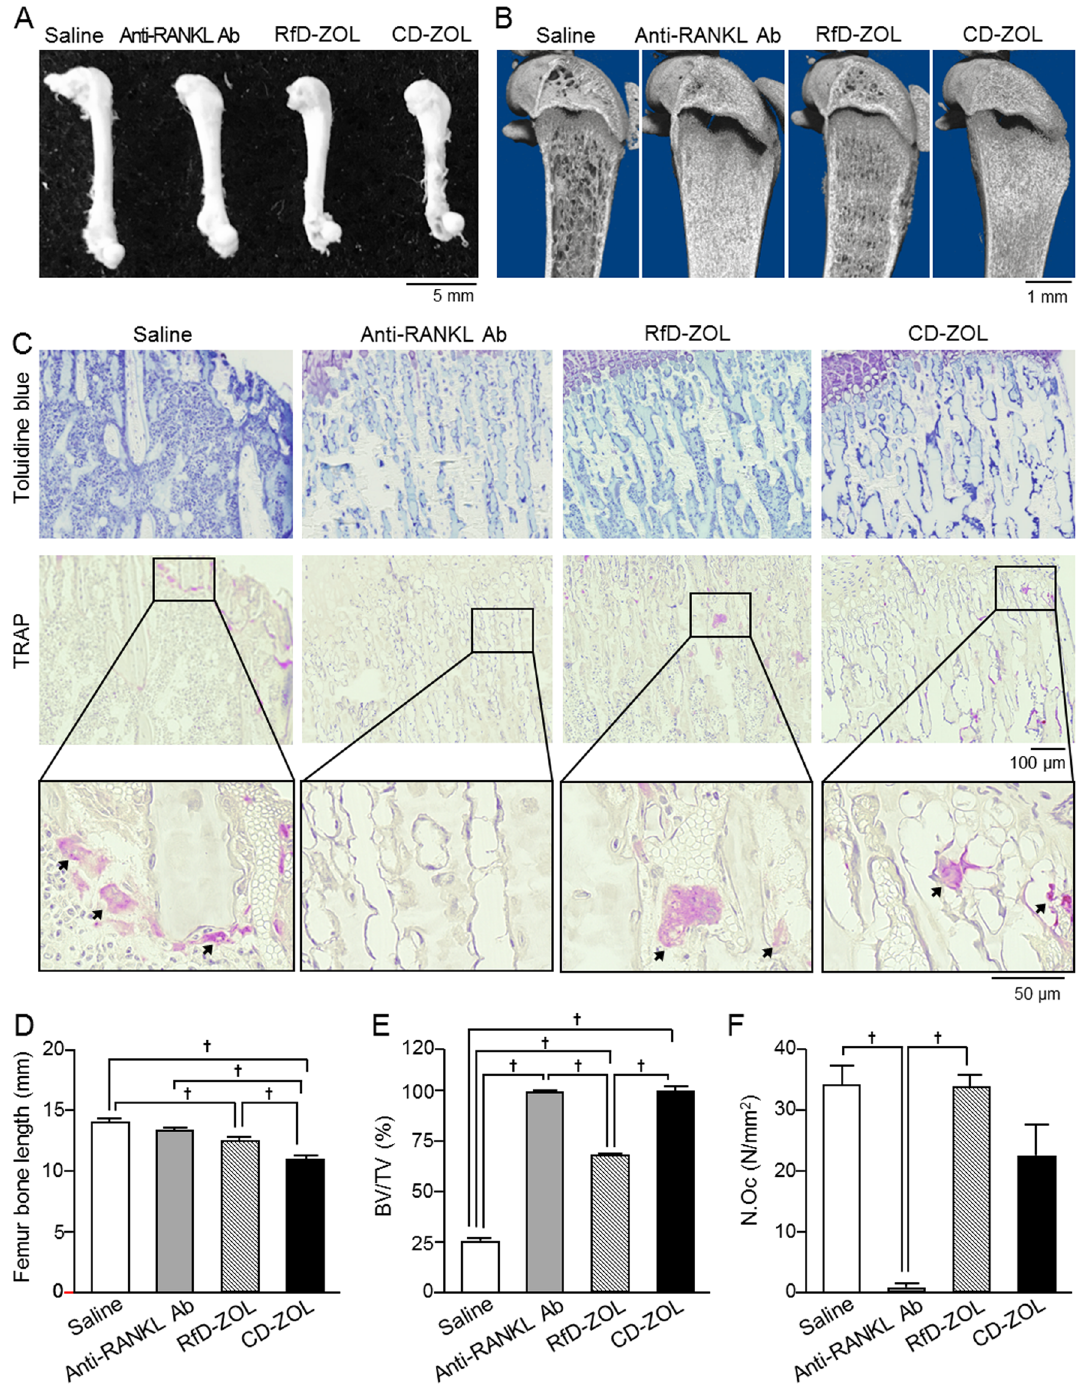
Figure 2. Effects of long-term administrations of anti-RANKL antibody or ZOL on femur and tibia. ( A ) Whole femur appearance. ( B ) Micro-computed tomography ( μ CT) findings of distal femurs in 8-week-old mice administered saline, anti-RANKL antibody (Ab) at 2.5 mg/kg, RfD-ZOL at 0.08 mg/kg, or CD-ZOL at 3.0 mg/ kg weekly for 7 weeks. ( C ) Findings following toluidine blue staining (upper) and TRAP staining (middle and lower) of proximal tibiae growth plate obtained from 8-week-old mice after weekly administrations of each drug for 7 weeks. Higher magnification images of black-boxed regions in middle panels are shown in lower panels. Arrows indicate TRAP-positive cells. Representative results are shown in ( A – C ). ( D ) Femur bone length. ( E ) Bone volume/tissue volume (BV/TV) ratios were determined by μ CT (saline, n = 6; anti-RANKL Ab, n = 5; Rfd-ZOL, n = 6, CD-ZOL, n = 5). ( F ) Number of osteoclasts (N.Oc) was determined in proximal tibiae following TRAP staining. Four mice from each of the saline, anti-RANKL Ab, RfD-ZOL, and CD-ZOL groups were used. Statistical differences were assessed by one-way ANOVA with Tukey-Kramer’s test. † Statistically significant different from compared to indicated groups, p < 0.05. Error bars represent